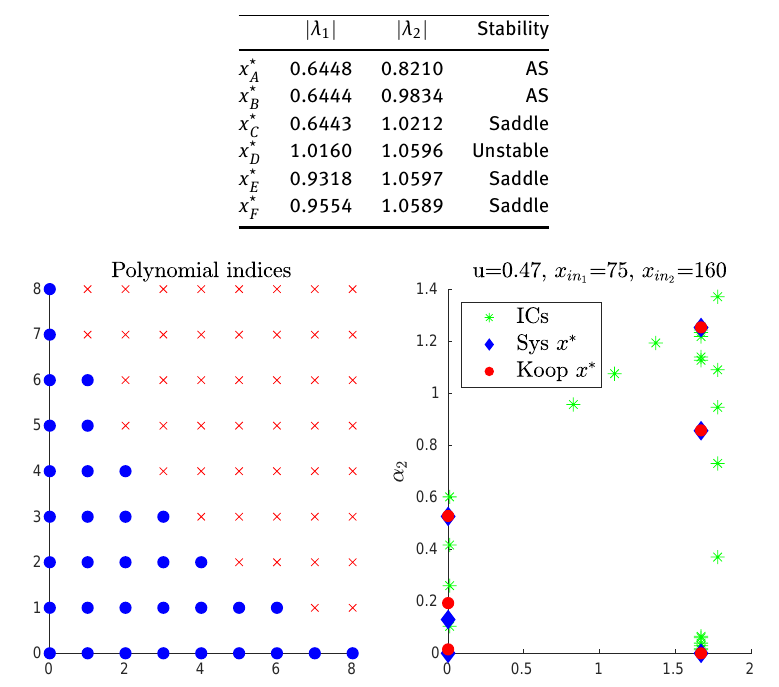
= 75 , and x in = 160 . 1 2